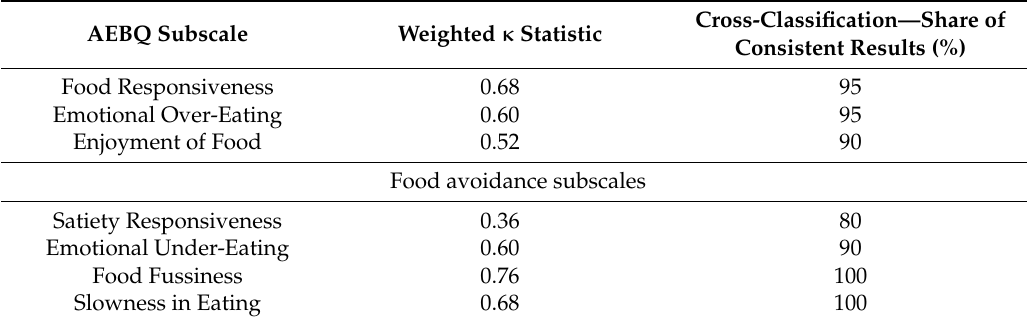
Table 2. Test–retest reliability of the Polish version of the Adult Eating Behavior Questionnaire (AEBQ) by Hunot et al. [9] ( n = 2448).